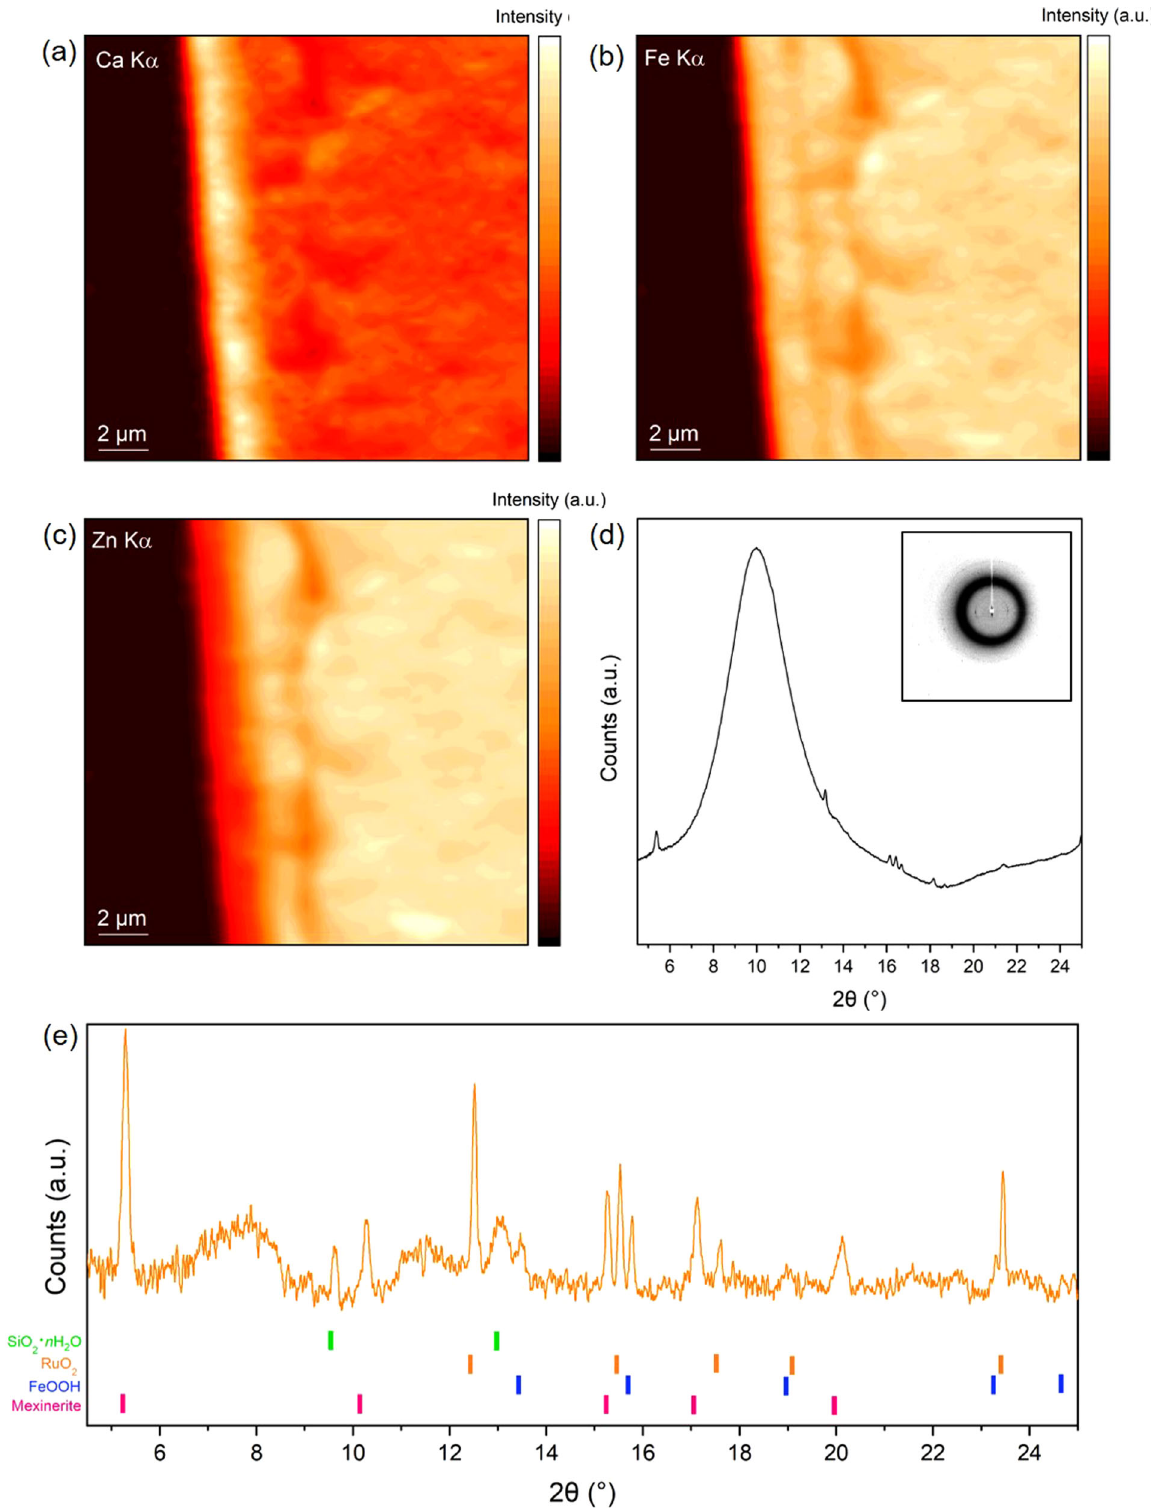
Fig. 6 Micro x-ray analysis of CaZn28 glass after 84 d of dissolution in Evolved Cement Water. Images showing the µ-XRF maps relating to the distribution of ( a ) Ca; ( b ) Fe; and ( c ) Zn. µ-XRD data are shown in ( d ) which depicts summed, un-calibrated, µ-XRD patterns with a 2D XRD pattern inset; and ( e ) showing the background subtracted, summed µ-XRD data. Phases were indexed as FeOOH (PDF #01-074-3080), meixnerite